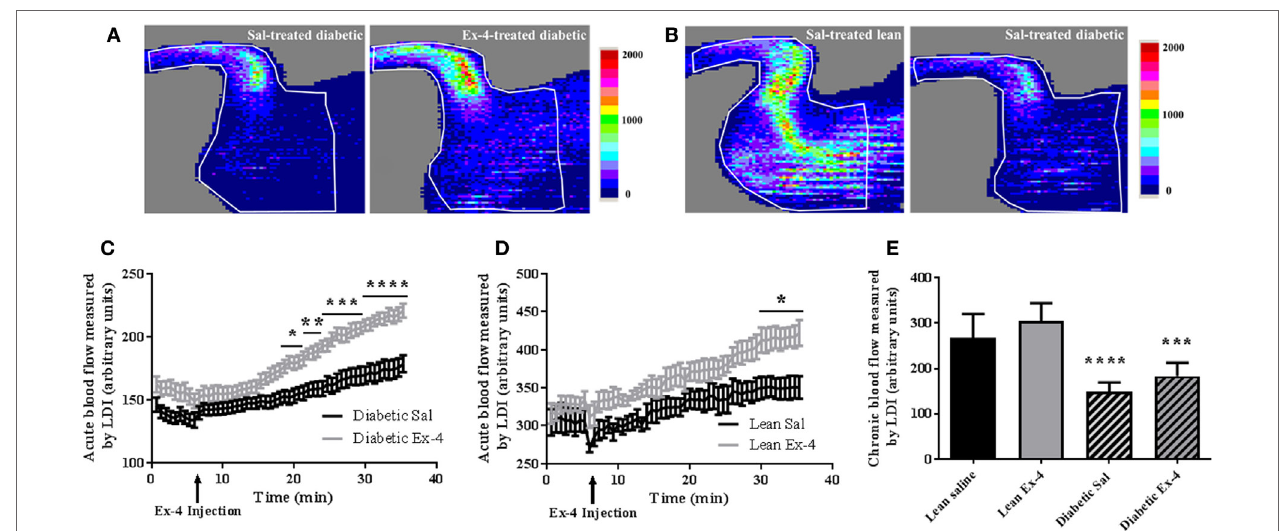
FigUre 2 | Acute and chronic effects of Exenatide on hindlimb blood flow in db/db mice and control mice. (a,B) Representative images of mouse hindlimb perfusion, obtained by laser Doppler imaging (LDI). (a) Blood flow imaging of db/db mice with saline injection versus Exenatide. Images were acquired after a 25 min infusion of saline or Exenatide (10 μ g/kg/day), (B) blood flow imaging of untreated lean mice versus db/db mice. Images were acquired after the 4 weeks of treatment. The colors in the heat maps indicate the maximum (red) and the minimum (blue) levels of perfusion, expressed in arbitrary units, representing the total blood flux (combination of velocity and concentration of red blood cells). (c,D) Time course graph of the average hindlimb perfusion monitored by LDI after Exenatide injection in db/db (c) and lean (D) mice. Exenatide (10 µg/kg) and saline were injected to mice after 8 min of baseline recording. Values are presented as mean ± SEM of n = 10 mice/group, * P < 0.05; ** P < 0.01; *** P < 0.001; **** P < 0.0001 versus saline. (e) Differences in hindlimb blood flow measured by LDI between the groups after 4-week treatment with Exenatide. Bars represent mean ± SD of n = 10 mice/group, **** P < 0.0001 versus lean mice.